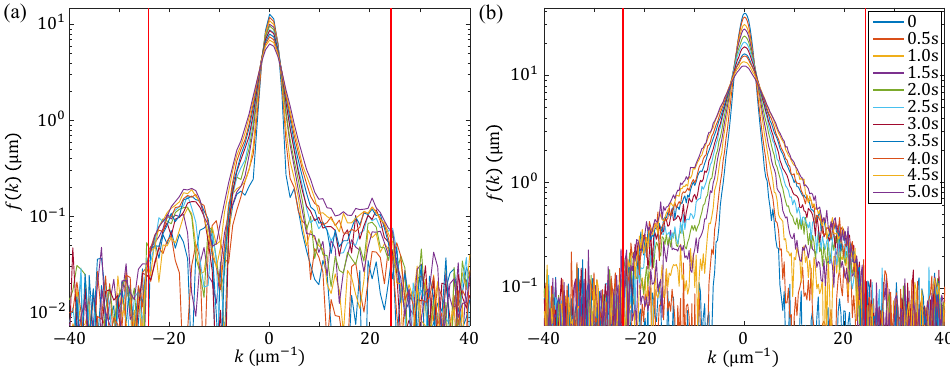
Figure 11: Time evolution of MDF for 1D gases held in lattice without Bragg